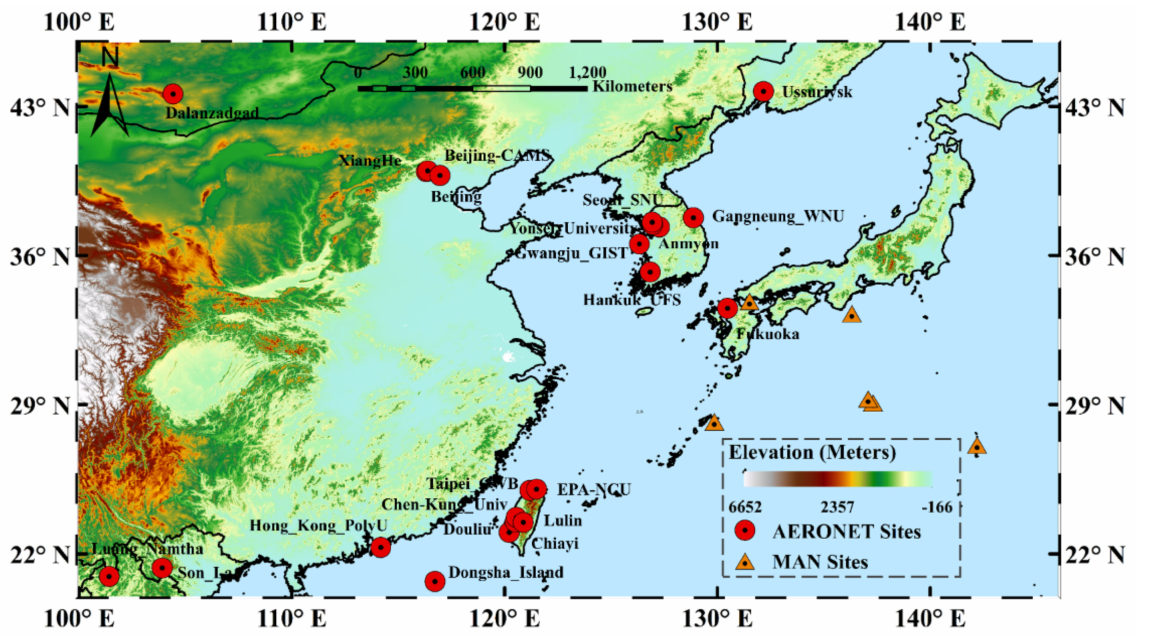
Figure 1. Spatial distribution of 22 AERONET (red circles) and MAN (brown triangle)